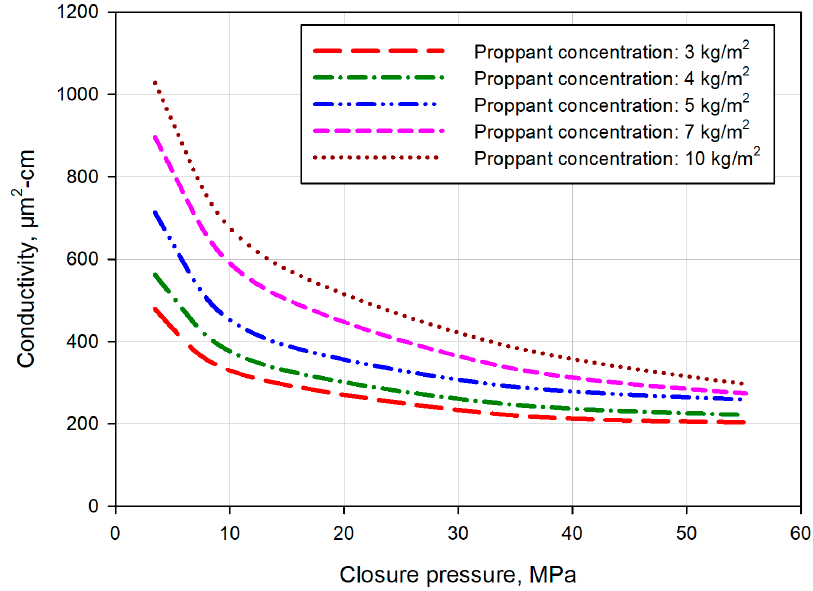
Figure 12. Conductivity evolution of fishbone intersecting pattern fractures with different proppant concentrations.